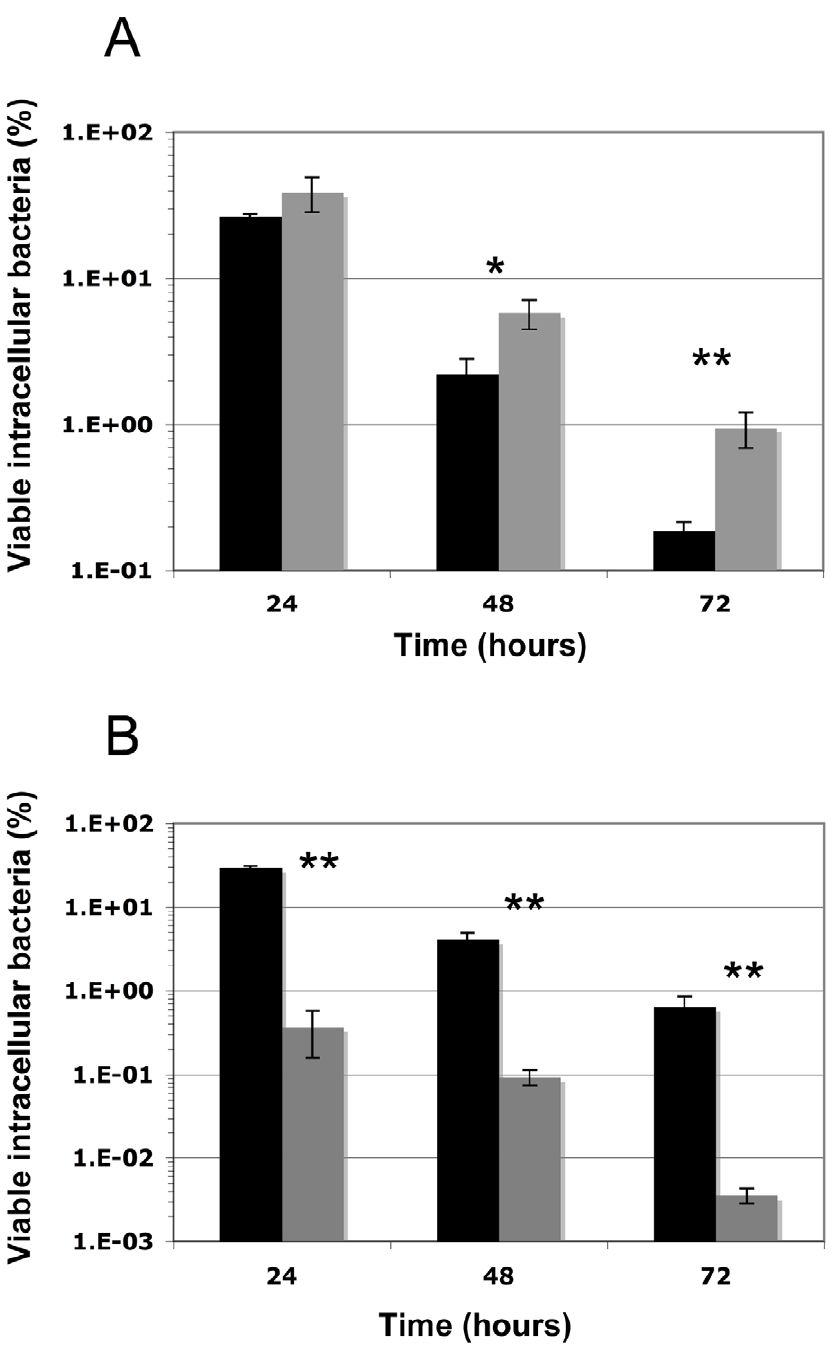
Figure 4. Intracellular survival of S.aureus SH1000, the D cymR and sodAsodM mutants in RAW 264.7 macrophages. Macrophages were infected as described (See Materials and Methods) with the SH1000 parental strain (black) or the D cymR mutant (panel A) or the sodAsodM mutant (panel B) (grey). Viable intracellular bacteria at 24, 48, and 72 h were counted and expressed as a percentage of internalized bacteria. One representative experiment (out of 3) is shown, performed in triplicate (means 6 SD). *: P , 0.05; **: P ,